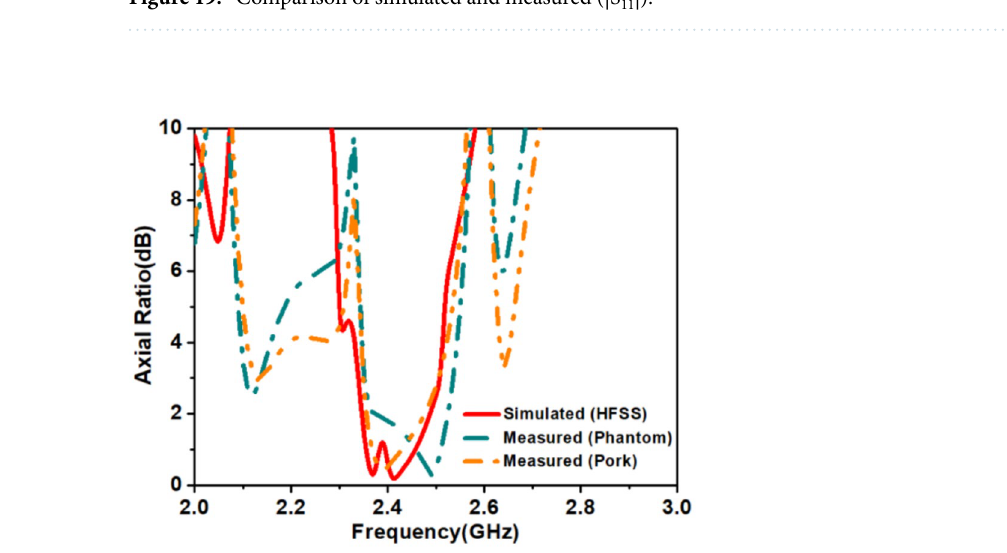
Figure 20. Comparison of simulated and measured